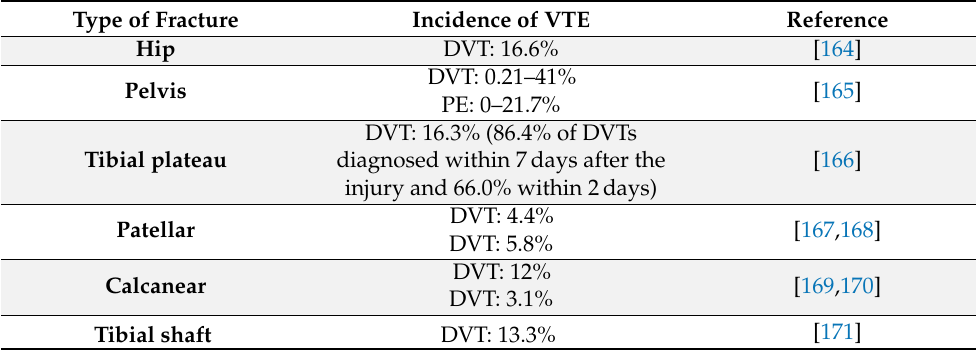
Table 5. Incidence of VTE according to the type of